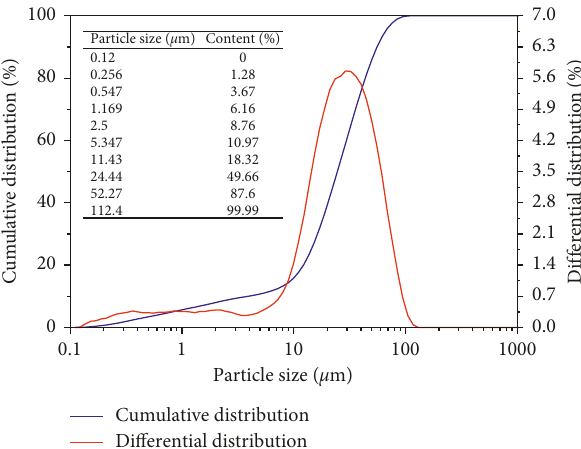
Figure 6: The particle size distribution diagram of OPPTA at room